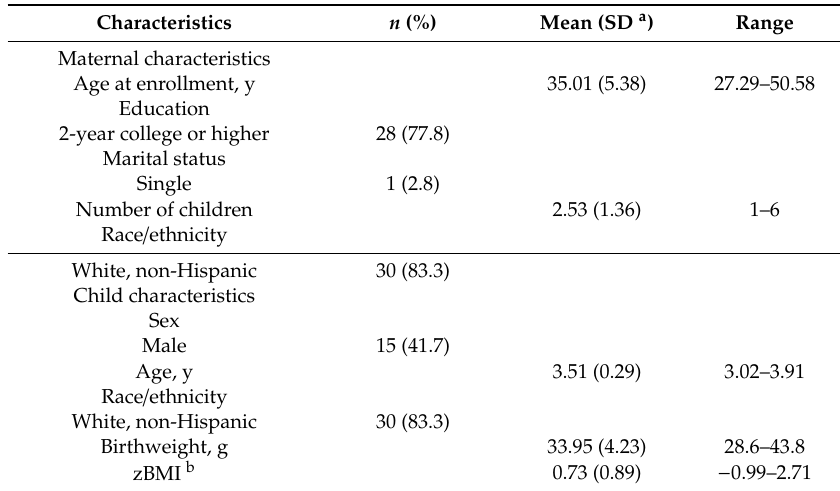
Table 1. Characteristics of eligible dyads ( n = 36).